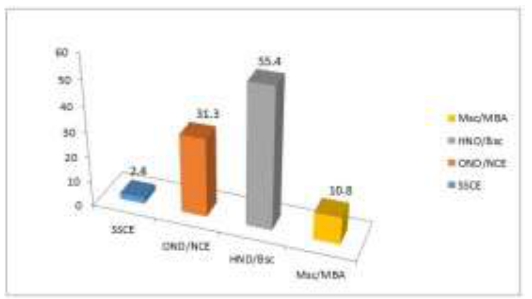
Figure 1. Educational Level of the